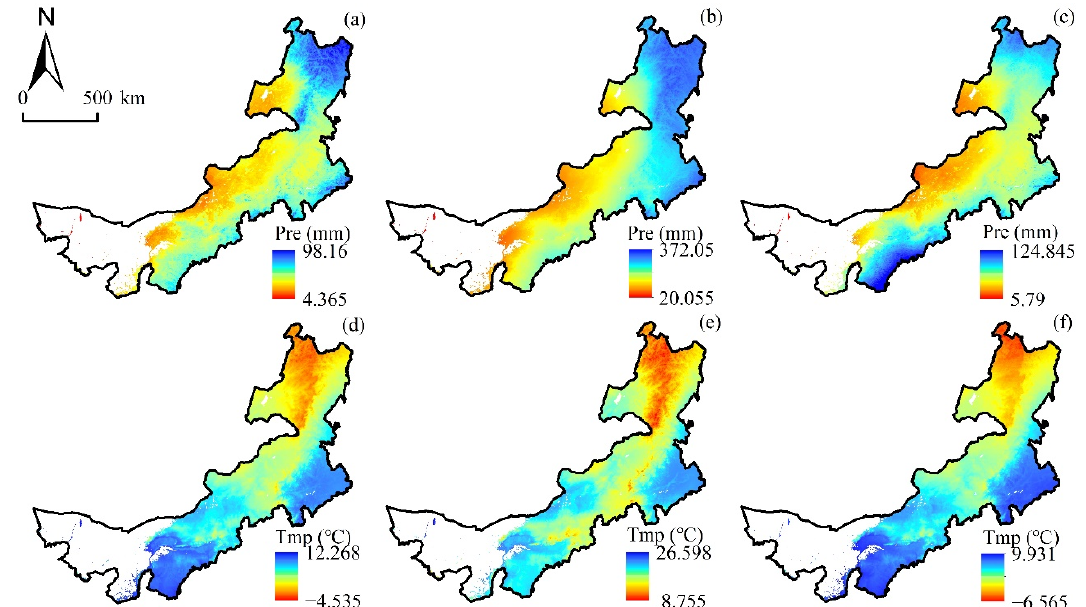
Figure 2. Spatial distribution of precipitation and temperature in different seasons. in Inner Mongolia. ( a – c ) Precipitation (Pre) for spring, summer and autumn, ( d – f ) temperature (Tmp) for spring, summer and autumn.